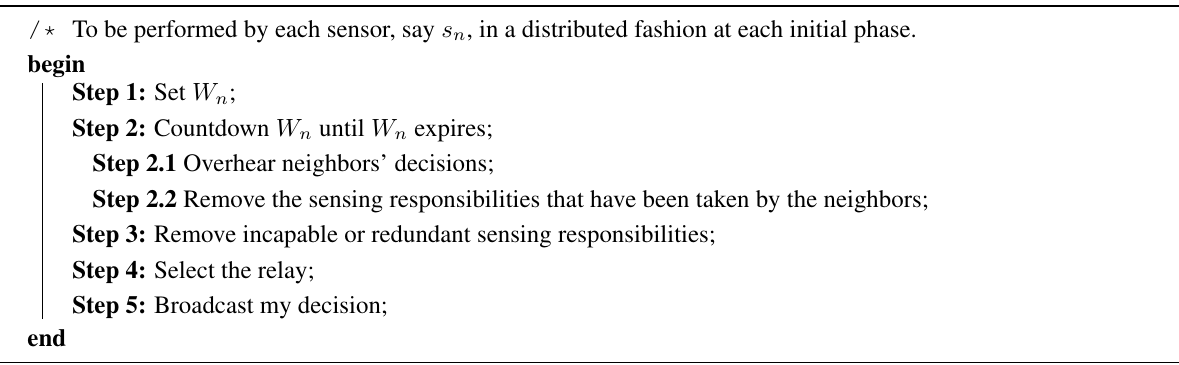
Algorithm 1 : A generic approach to the MU-CTC